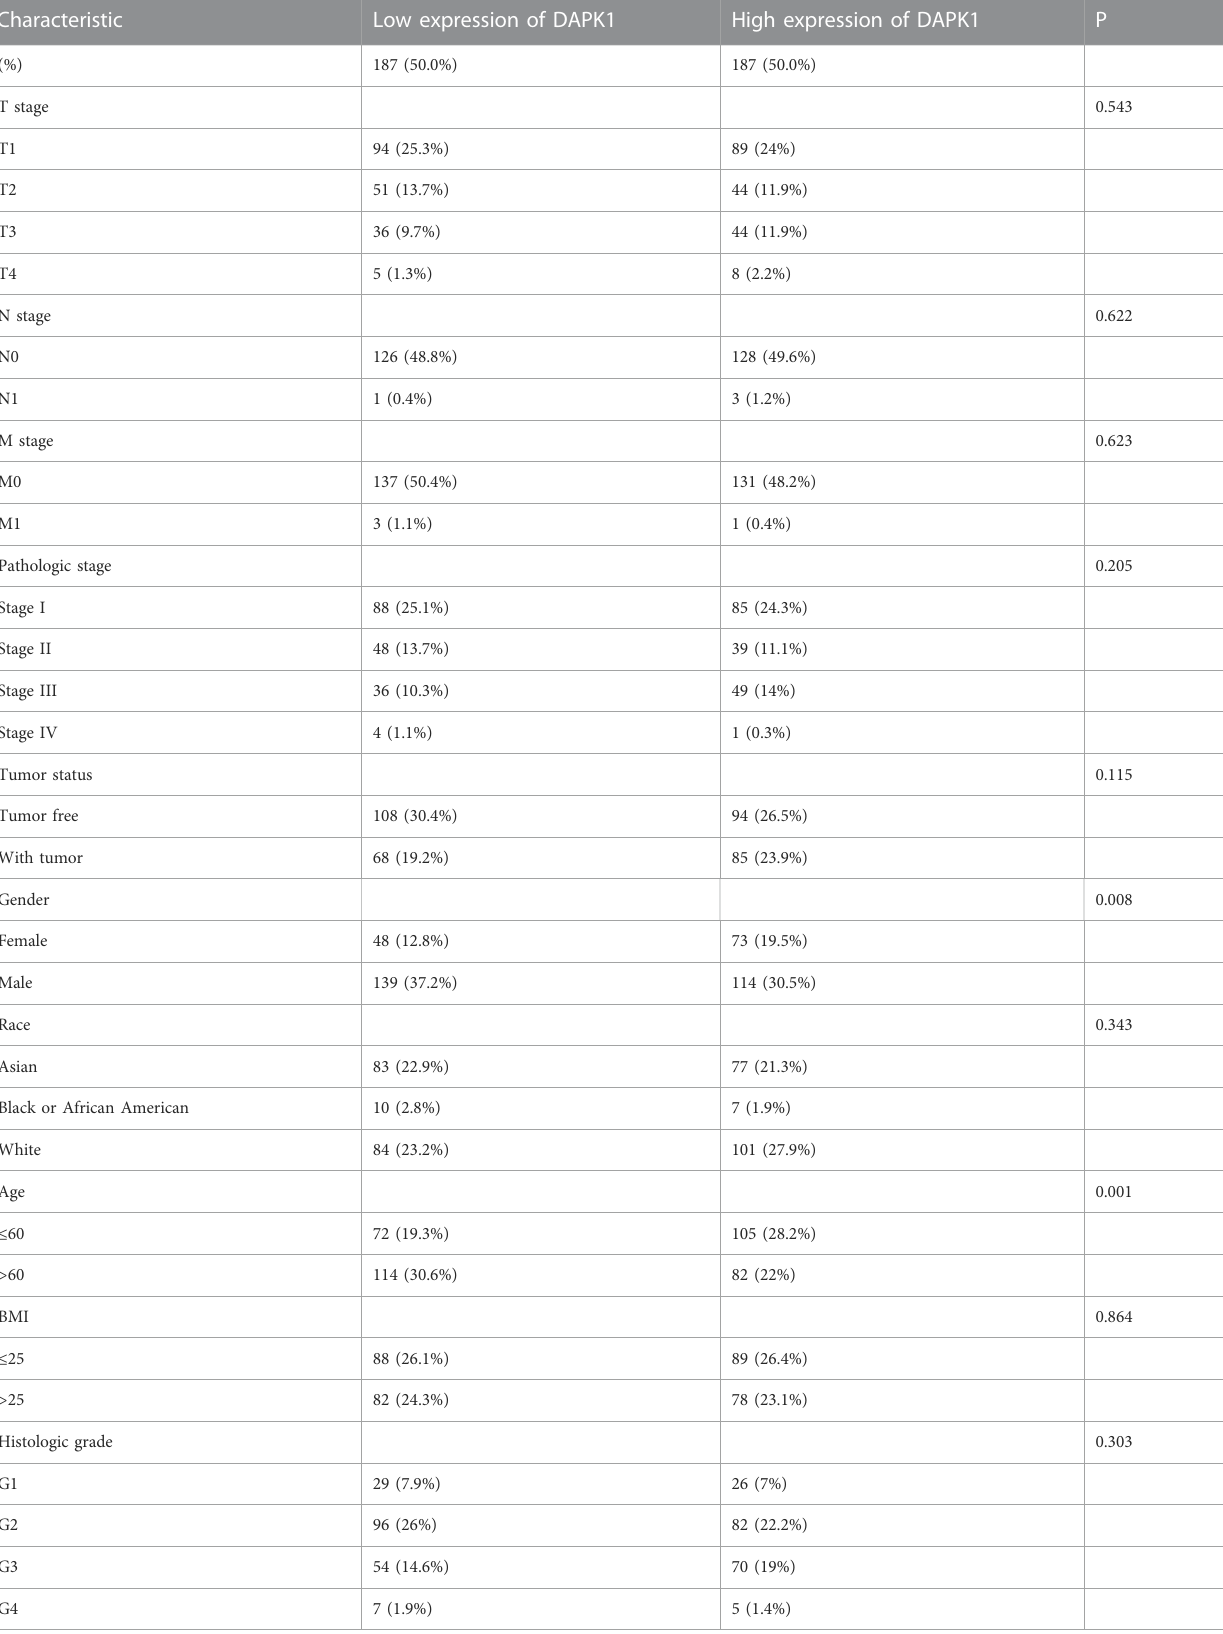
TABLE 1 Correlation between DAPK1 expression levels in HCC samples and clinicopathological parameters.